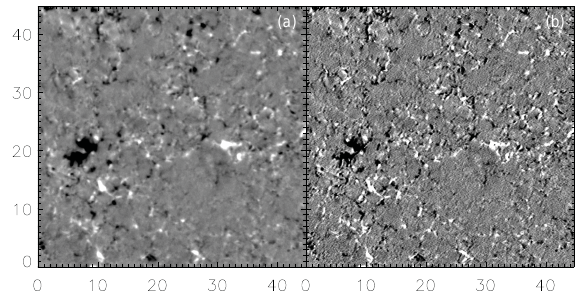
Figure 4. Line-of-sight magnetic field from (b) the IMAX instru- ment on the Sunrise balloon and (a) the same data at the resolution of the Hinode mission. The bipolar fragments (black and white next to one another) represent emerging flux if they are separating and cancelling flux if they are approaching. Distances are measured in arcsec, where 1 arcsec represents 726km on the Sun (courtesy of Sami